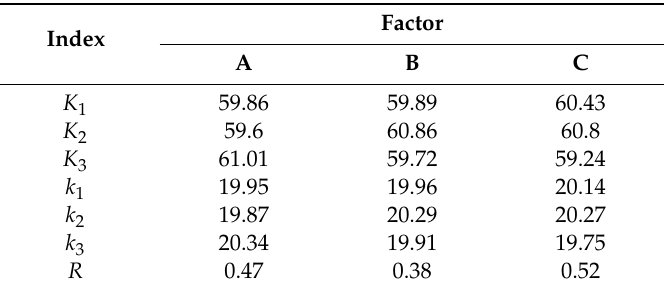
Table 10. Range analysis of